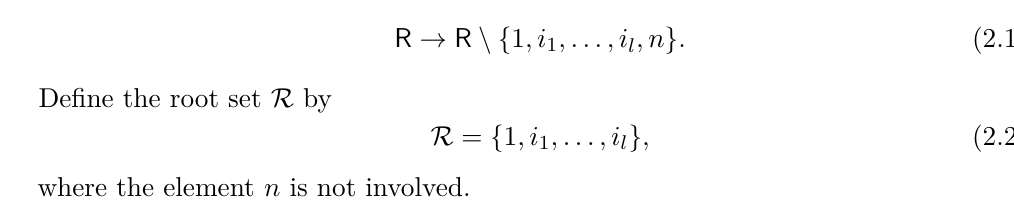
Figure 1 . The master chain of the form (a) corresponds to a factor ( − 1) n − l (cid:15) 1 · F i If { i = ∅ , the master chain becomes (b) which contributes a factor ( − 1) n (cid:15) 1 , . . . , i l } defined by step-3 and -4 has the general form (c), which stands for a factor (cid:15) special case with { i = ∅ is given by (d), corresponding to the factor (cid:15) 1 , . . . , i l } shown by